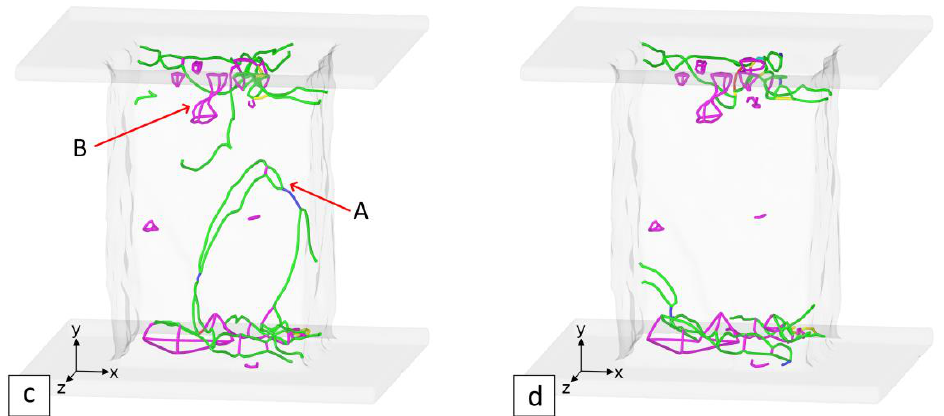
Figure 5. The evolution of the dislocation structure of Ni single crystal at strain: ( a ) 16.8%; ( b ) 17.1%; ( c ) 18.6%; and ( d ) 18.8%.